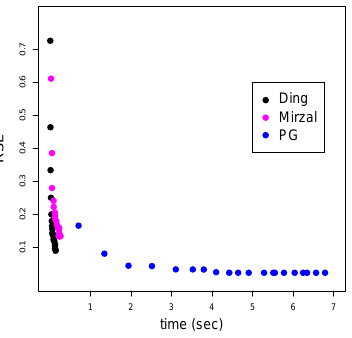
Values of RSE vs. the number of outer iterations, for the noisy BION data. Figure 6. This figure depicts how RSE is changing with the number of outer iterations (left) and with time (right), for all three algorithms. Computations are done on the noisy BION data set with µ = 10 − 2 , for n = 200 and the inner dimension was equal to the true inner dimension ( p = 100